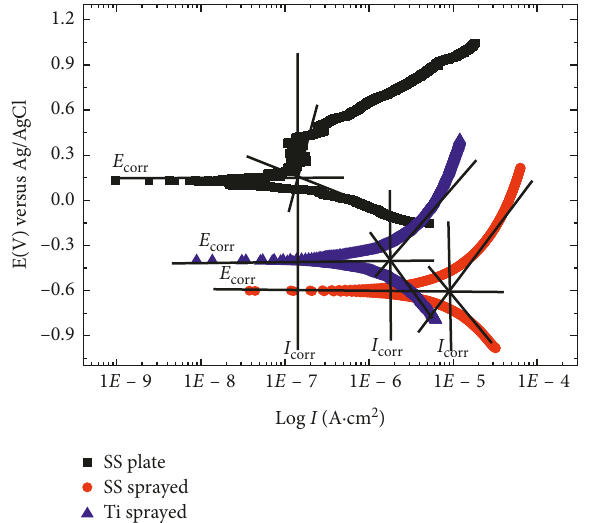
Figure 6: Potentiodynamic plots of the SS plate and sprayed coatings in pH 4 solution after 312h of exposure (1